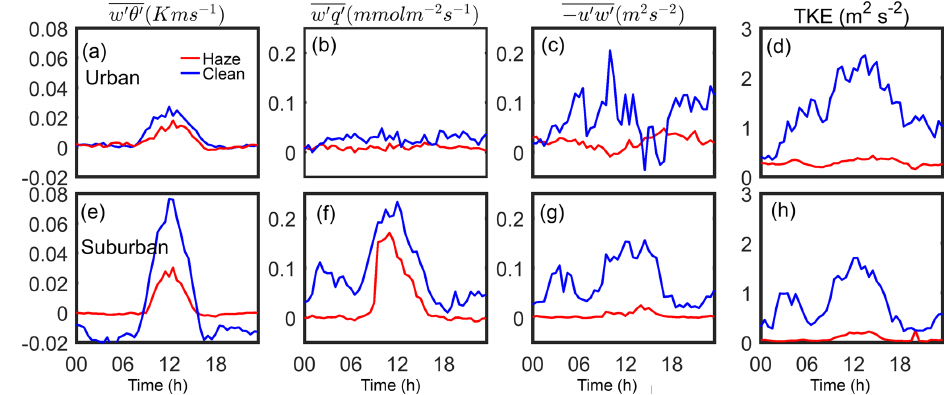
Figure 11. Diurnal variations in the mean vertical heat flux ( w (cid:48) θ (cid:48) ) (a) , vertical water-vapour flux ( w (cid:48) q (cid:48) ) (b) , momentum flux ( − u (cid:48) w (cid:48) ) (c) , and TKE (d) under polluted weather (red solid line) and clear weather (blue solid line) conditions over the urban site. Diurnal variations in these variables over the suburban site are shown in (e) , (f) , (g) , and (h)